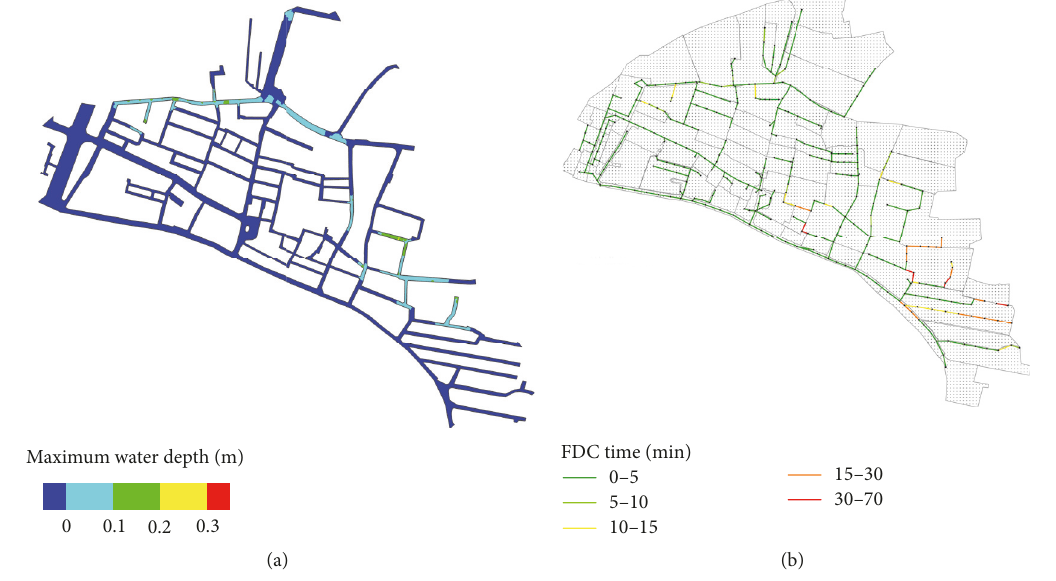
Figure 13: Results of rainstorm with a return period of 10 years: (a) maximum water depth; (b) FDC time. Table 6: Details of FDC pipes.